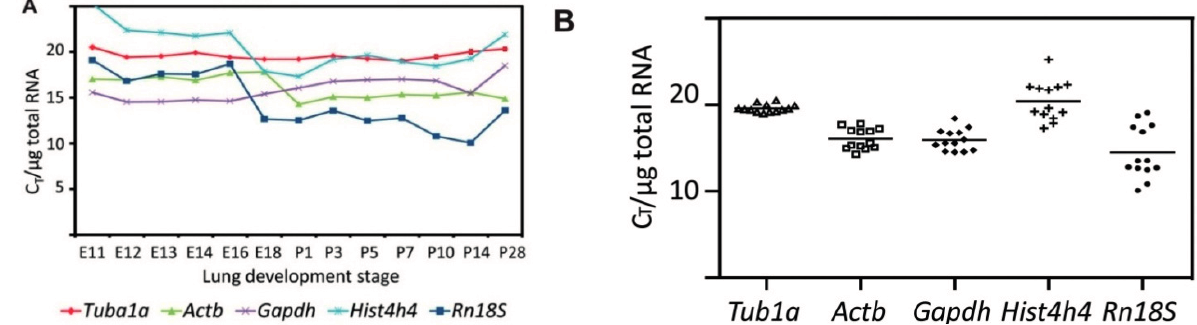
Figure 4. Expression analysis of the internal control genes evaluated in this study during different phases of lung development. ( A ) Variable cycle threshold ( C T ) for the different reference genes over mouse lung development. C T values were determined by qRT-PCR in triplicates for biological duplicates ( n = 6) at the indicated stages of lung